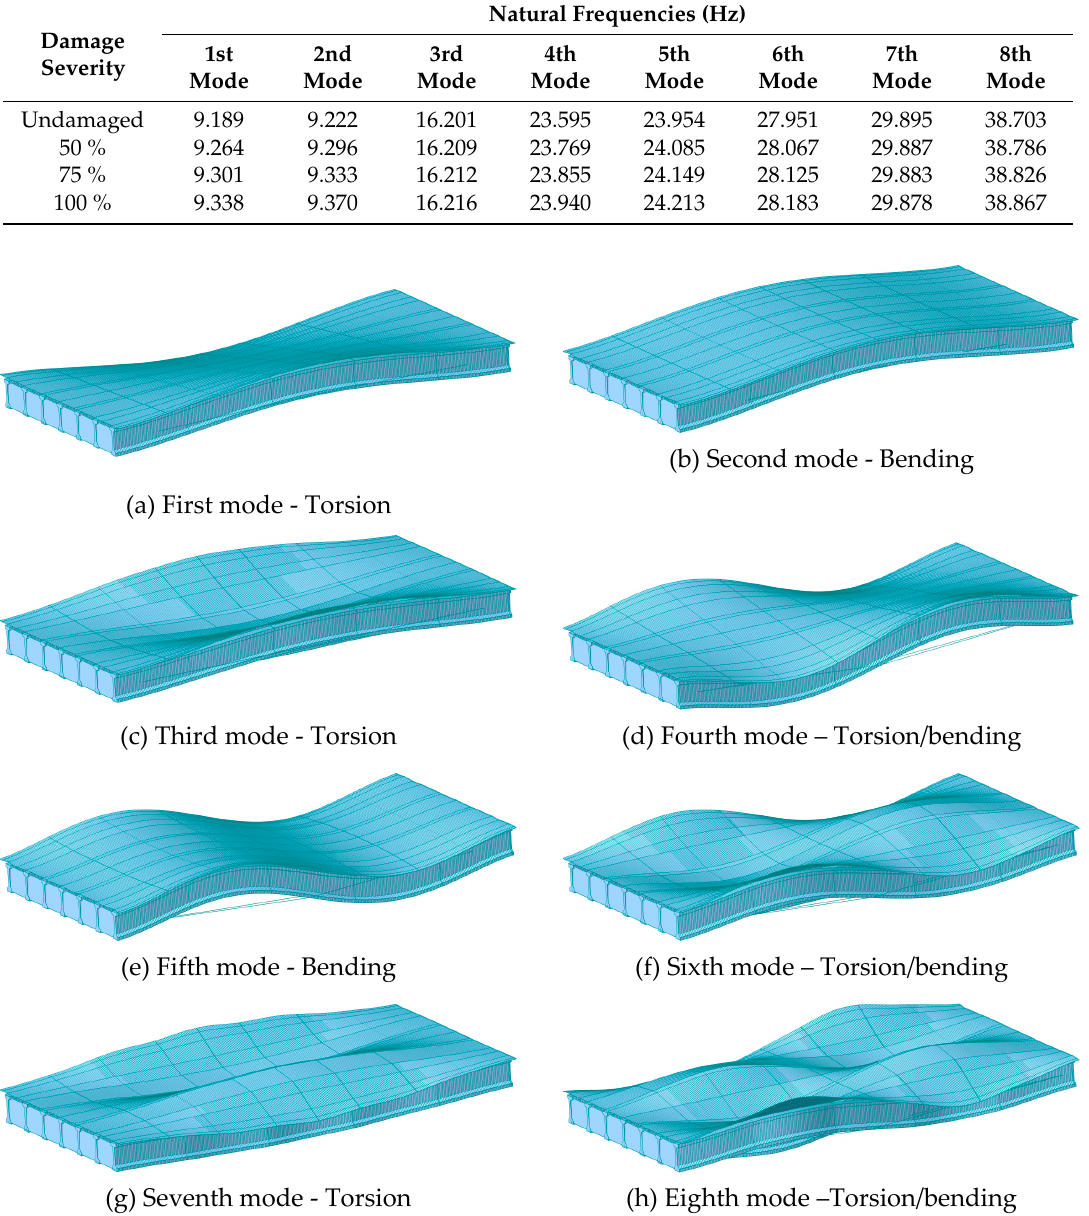
Figure 2. Mode shapes of modeled bridge (undamaged case).